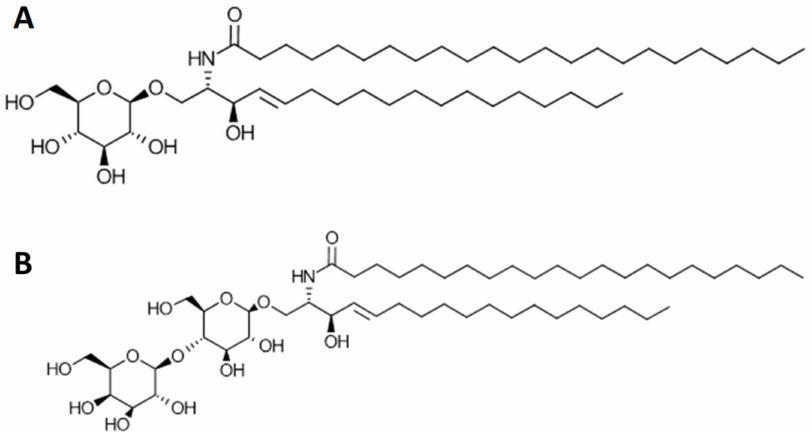
Figure 1. Schematic structures of glucosylceramide (GluCer) (d18:1 / 23:0, A ) and lactosylceramide (LacCer) (d18:1 / 22:0, B